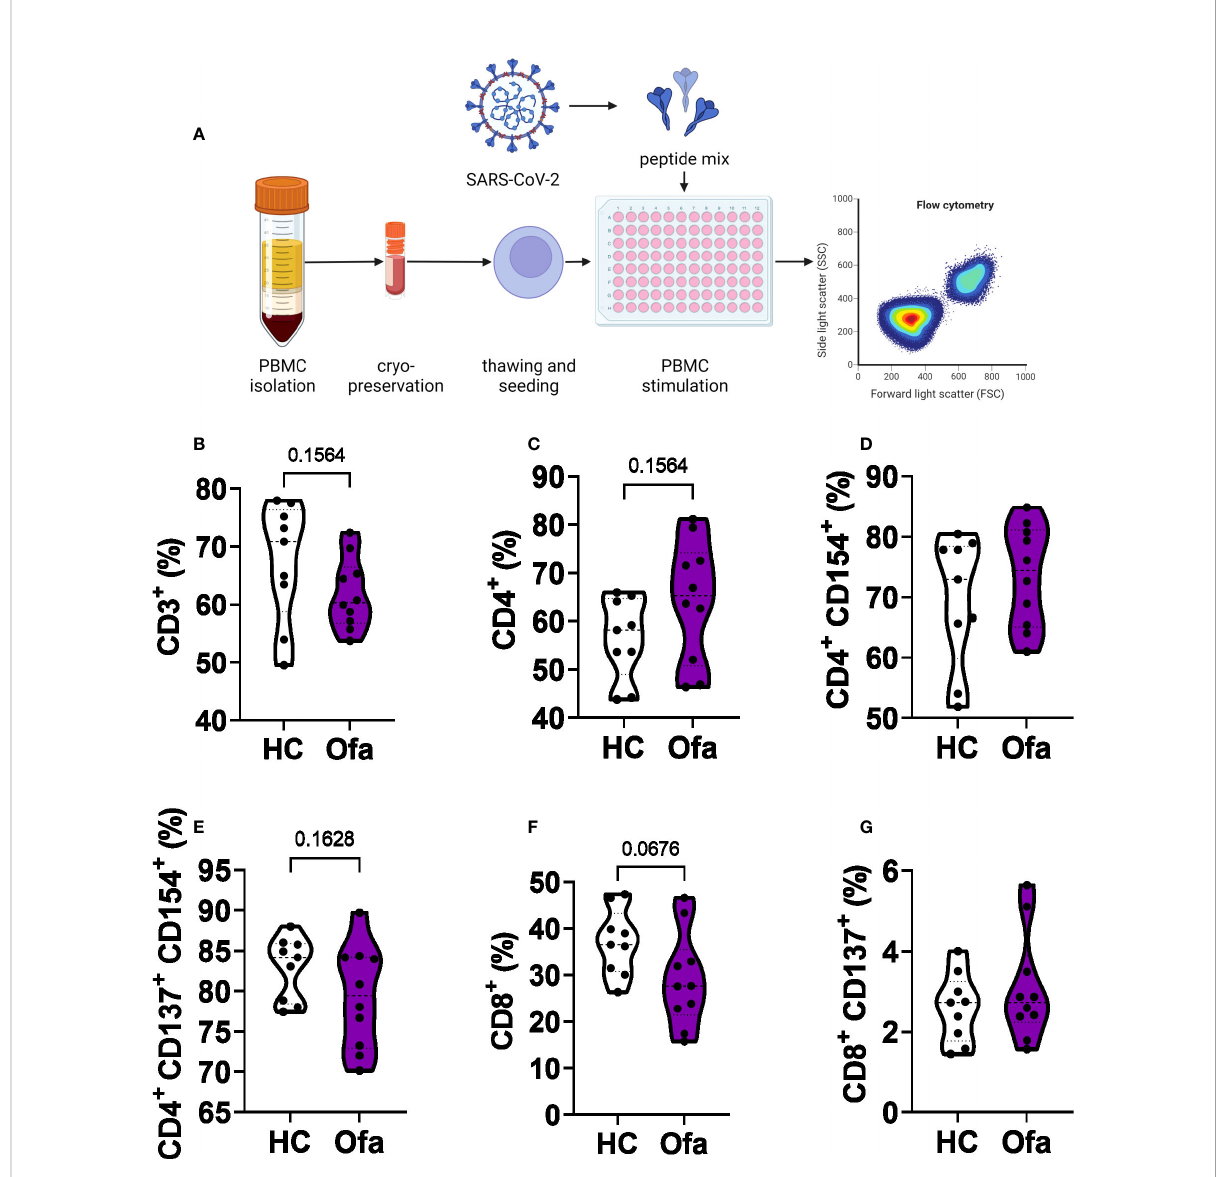
FIGURE 4 Flow cytometry analysis of T cell populations. (A) peripheral blood mononuclear cells (PBMCs) of Ofatumumab treated MS patients (Ofa) and healthy controls (HC) were collected 4-13 weeks following the third vaccination against SARS-CoV-2 and restimulated with a SARS-CoV-2 peptide pool followed by immunophenotyping via fl ow cytometry. SARS-CoV-2 peptide stimulated PBMCs showed (B) no altered frequencies of CD3 + T cells (p=0.1564) and (C) CD4 + T helper cells or (D, E) activated CD4 + T helper cells. (F) Frequencies of CD8 + T cells were lower in the Ofa group compared to HC (p=0.0676) while (G) activated Tc cells did not differ. Data were analyzed with a two-tailed Mann-Whitney U test. n=10 Ofa, n=9 HC. (A) Created with